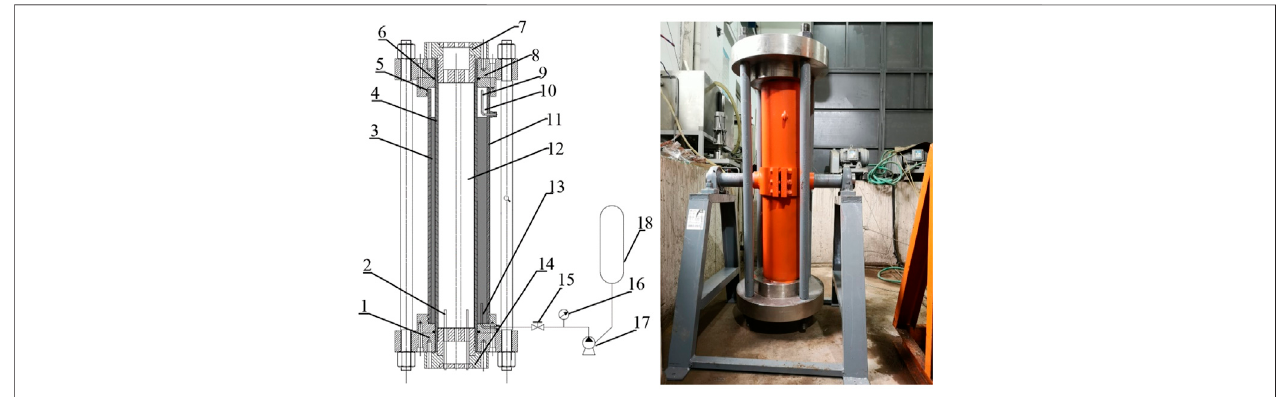
FIGURE 2 | Sealing integrity evaluation device for an eccentric cement sheath of a casing in a high-temperature and high-pressure full-size return section.